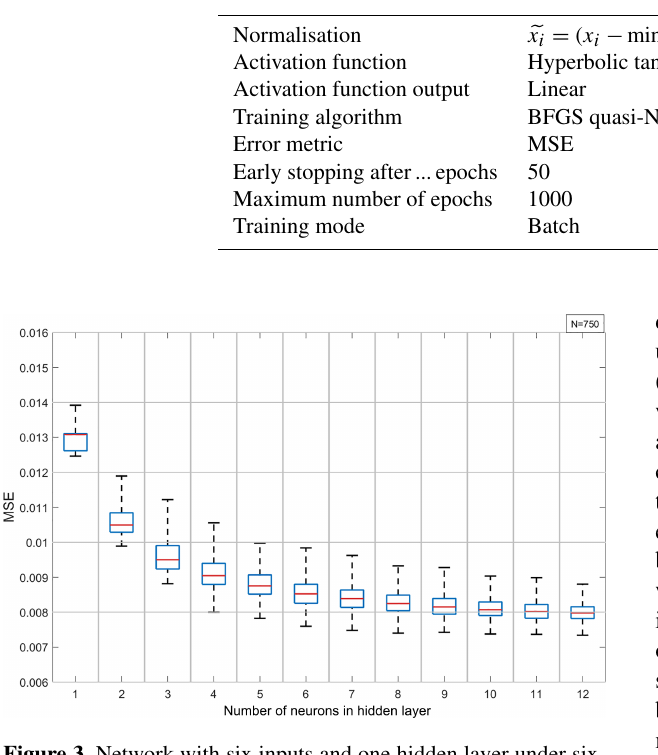
Table 3. Fixed network parameters for training (following Zhang, 2008; Kruse et al., 2016).